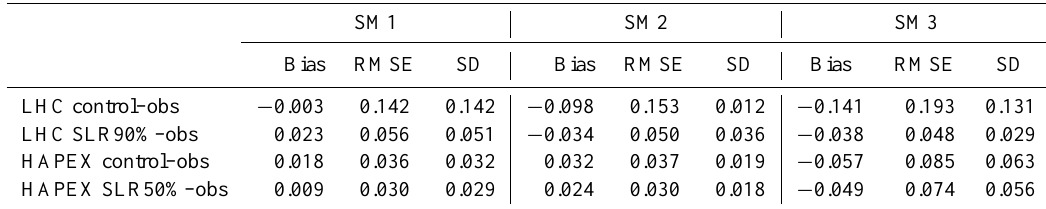
Table 3. The mean bias, root-mean-square error (RMSE) and standard deviation (SD) in simulated soil moisture compared to observations (obs). Control refers to simulations without the stem–root flow mechanism, and SLR90% or SLR50% are simulations with the optimal stemflow to leaf drainage ratio. Unit: m 3 m − 3 .